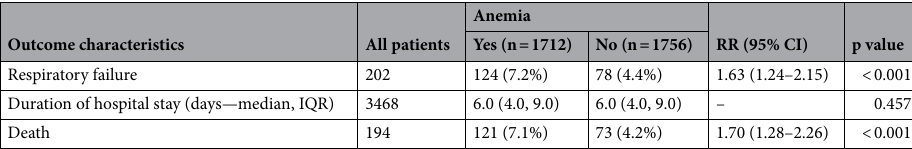
Table 2. Outcome of under-five children with anemia hospitalized for pneumonia/severe pneumonia. RR relative risk, CI confidence interval, IQR inter-quartile range, () %.